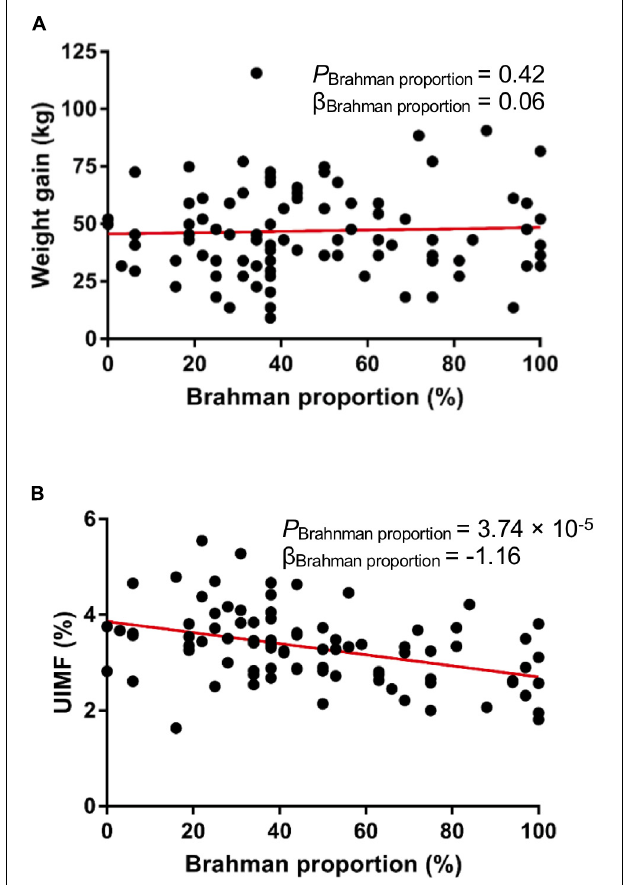
FIGURE 2 | Animal growth performance of the MAB postweaning heifers. There is no significant correlation between breed composition and weight gain (A) . Ultrasound percent of intramuscular fat (UIMF) was negatively correlated with Brahman proportion (B) .